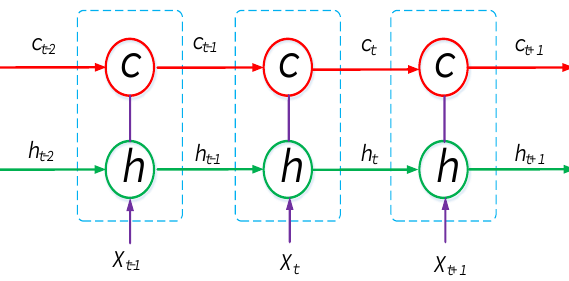
Figure 2. The temporal-logic framework of a single layer LSTM.